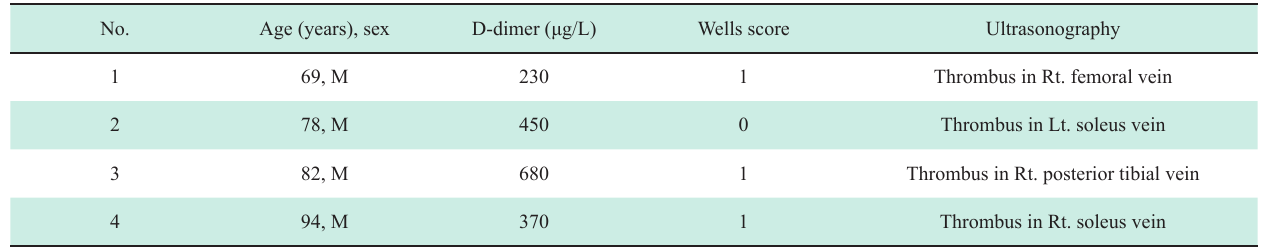
Note: the cases 1, 2, and 4 ruled out DVT using both conventional and age-dependent cut-off value. The case 3 missed by age-dependent cut-off